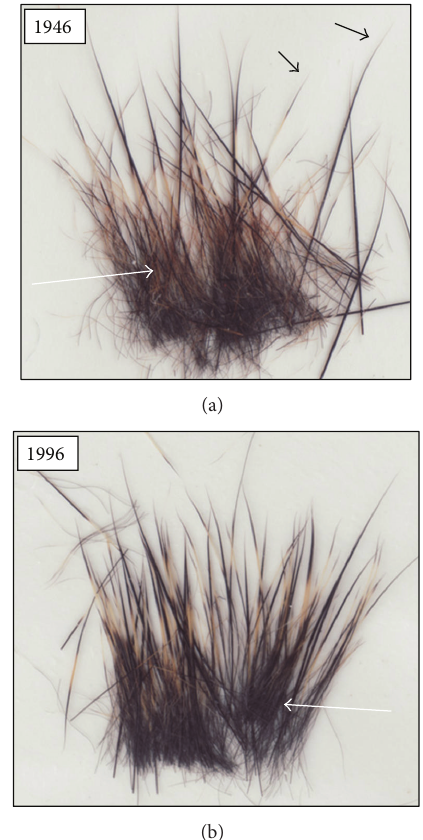
Figure 4: Scans of hair samples taken from an older chipmunk specimen and a newer chipmunk specimen, to show differences in color. Hair samples were scanned on a flatbed scanner with no color correction. Samples were cut from the agouti fur on the dorsum of the specimens. Note the red coloring of the fine body hair in the older specimen, compared to the newer specimen (white arrows) andthatthereisnobreakageofhairtipsintheolderspecimen(black